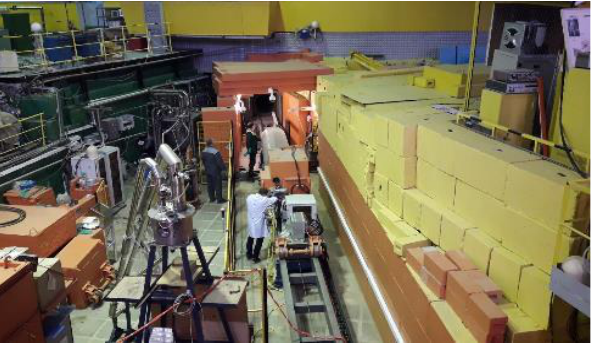
Fig. 6. Experimental channel of the IBR-2 reactor, where the detector module mockup was placed during the tests.